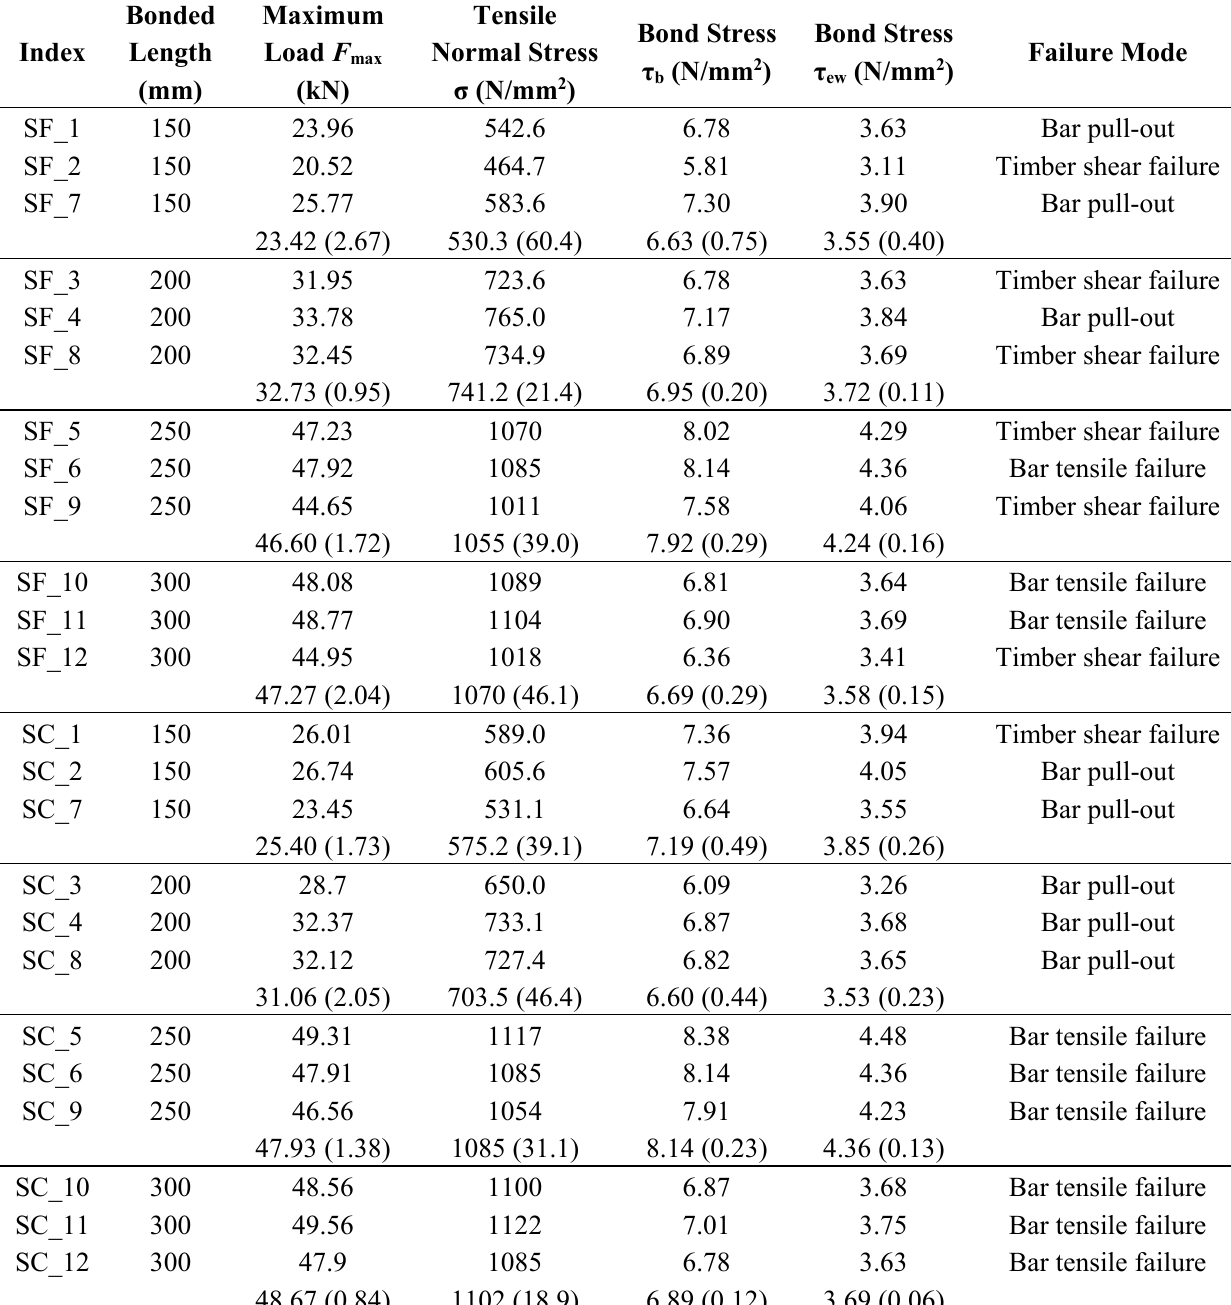
Table 3. Test results. SF, fir specimen; SC, chestnut